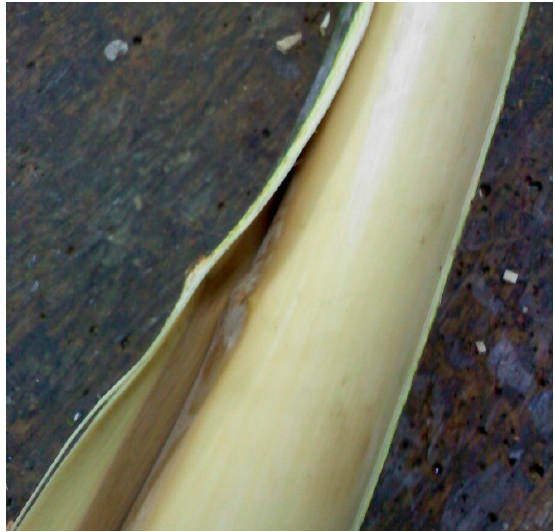
Figure 1. Mechanical bark separation.